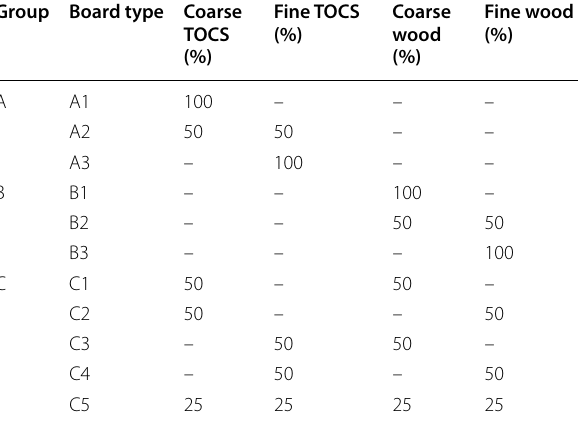
Table 2 Particle ratio of single layer TOCS